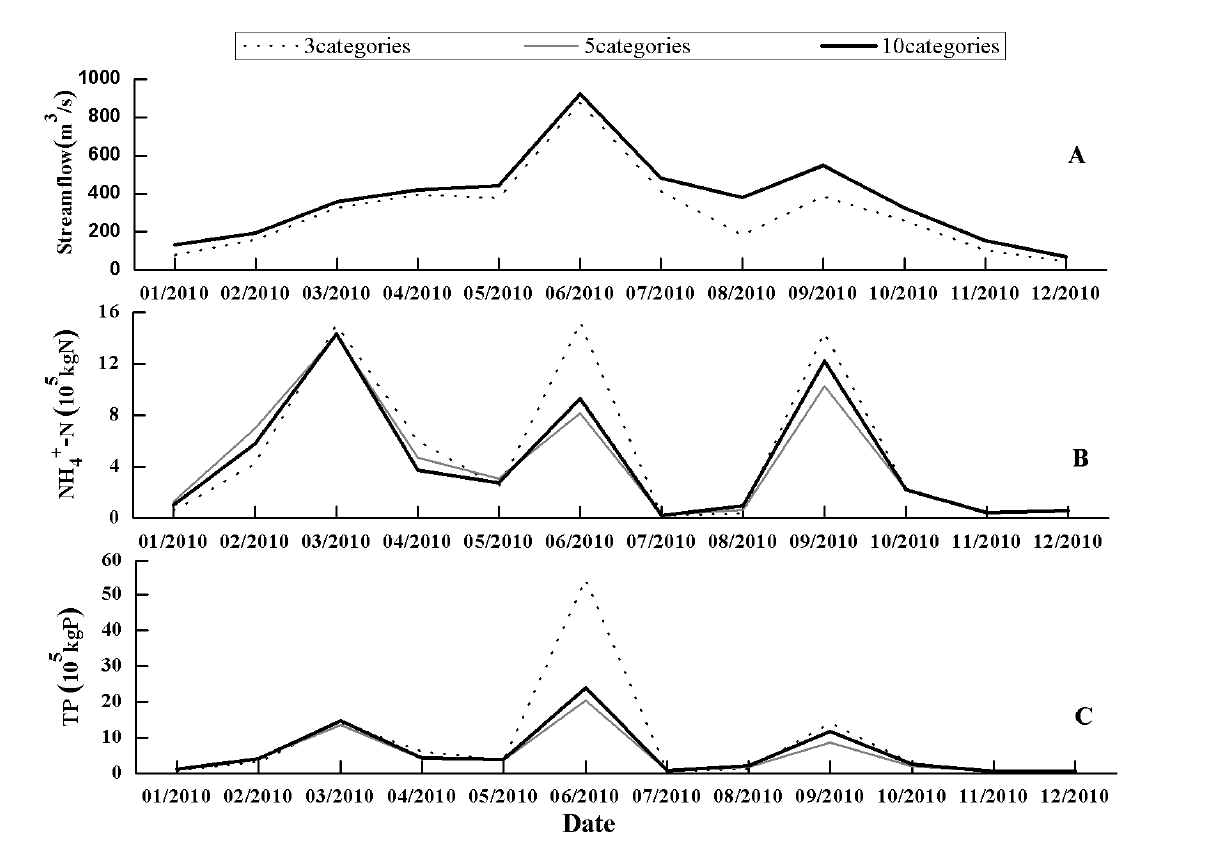
+ -N ( B ) and TP ( C ) loads 4